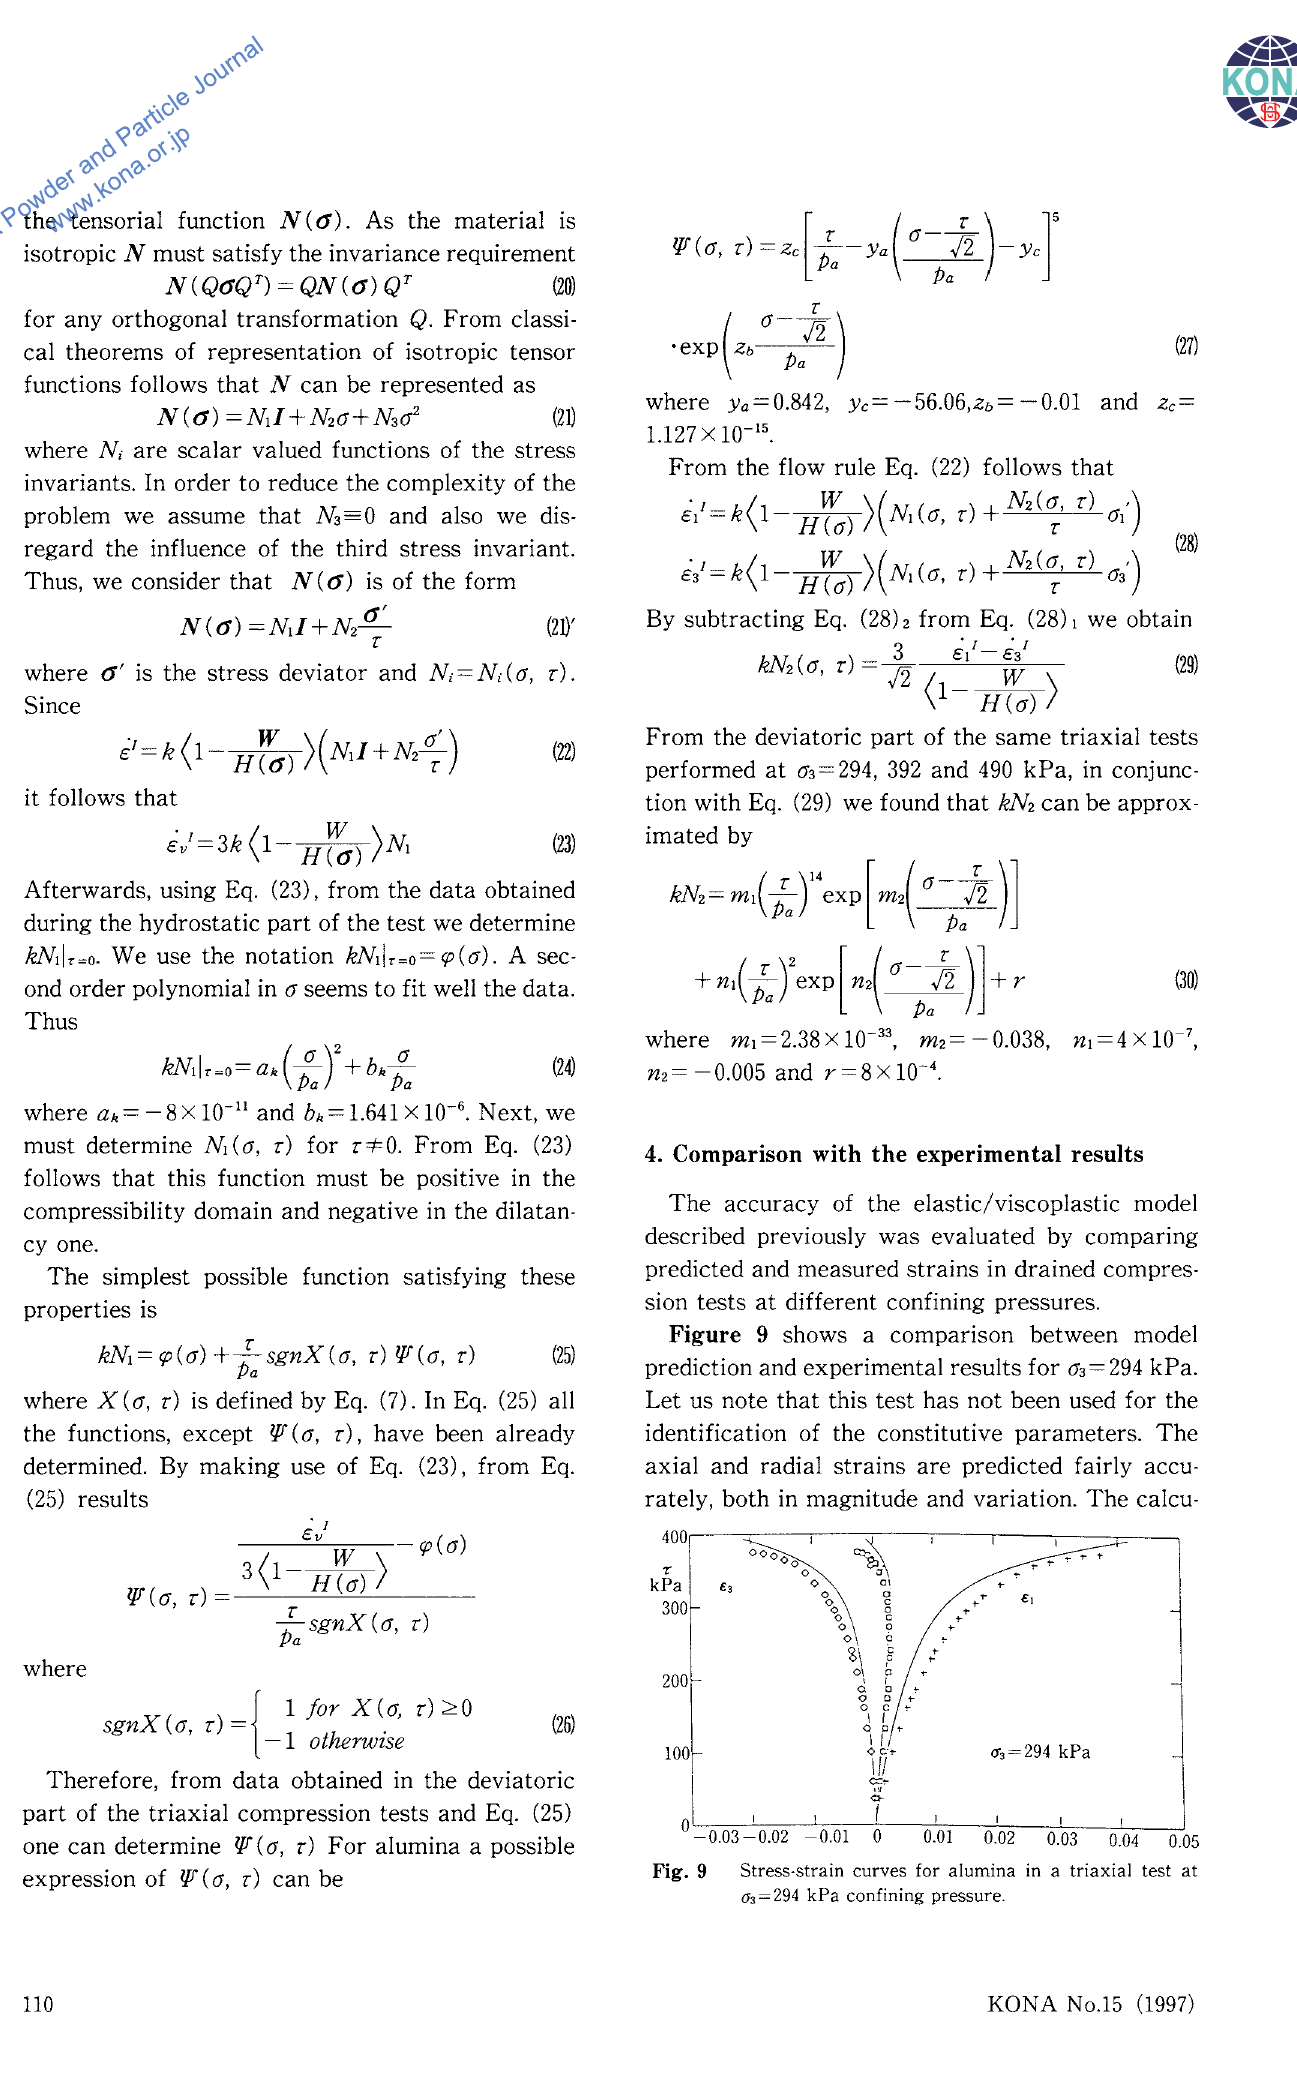
Fig. 9 Stress-strain curves for alumina in a triaxial test at o 3 = 294 kPa confining pressure.